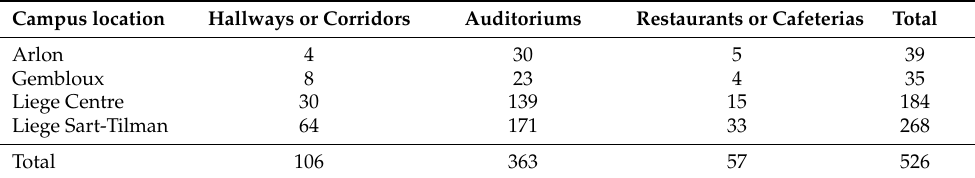
Table 1. Distribution of observation sessions per campus and locations of observations.